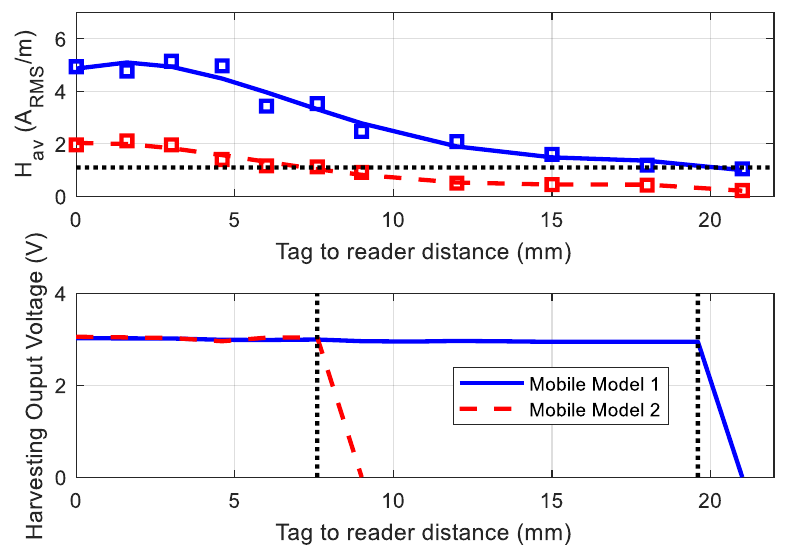
Figure 9. Measured average magnetic field ( top ) and harvesting output voltage ( bottom ) as a function of the tag-to-reader distance for two mobile models. We can see that, once the magnetic field goes below the threshold, the voltage output falls to zero.